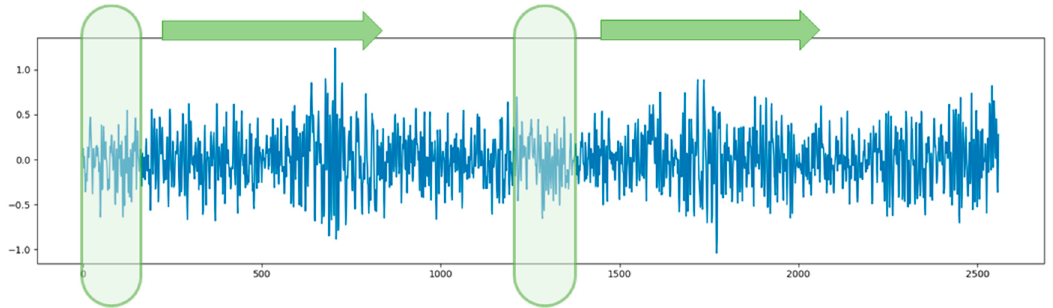
Figure 6. A two-channel filter slides at the first half part and the second half part at the same time.